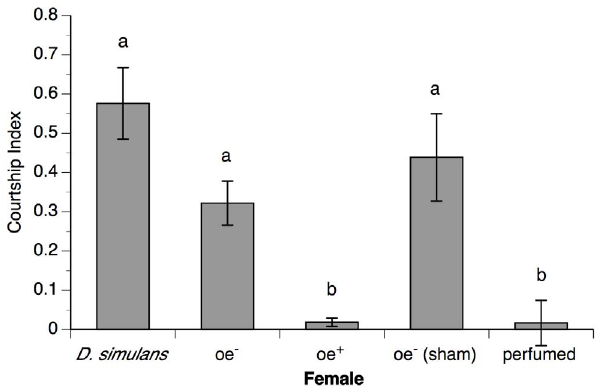
Figure 1. Preferences of D.simulans males. Mean courtship indices for D. simulans males when paired with: D. simulans females, oe 2 D. melanogaster females (lacking CHCs), oe + D. melanogaster females (expressing CHCs), sham-perfumed oe 2 females and oe 2 females perfumed with D. melanogaster female CHCs. Error bars indicate standard errors, and columns labeled with different letters are significantly different from one another (pairwise Wilcoxon tests followed by sequential Bonferroni adjustment, p , 0.05).